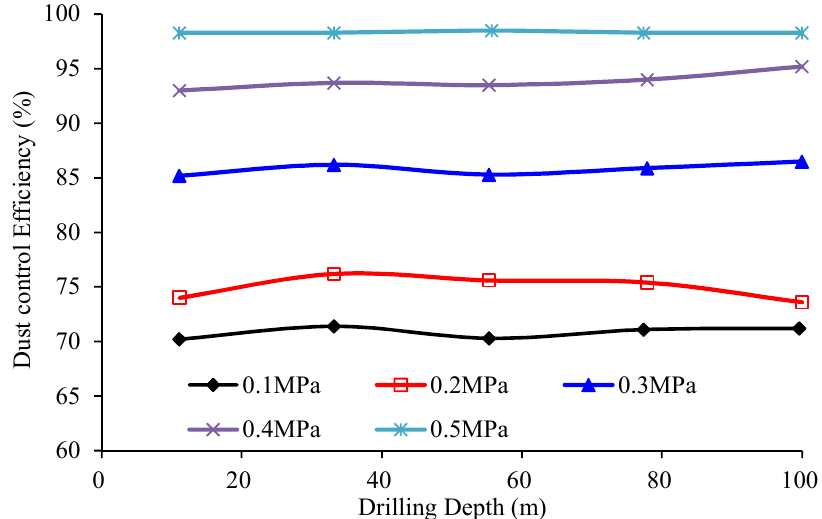
Figure 8. Dust control efficiency at different drilling depths.